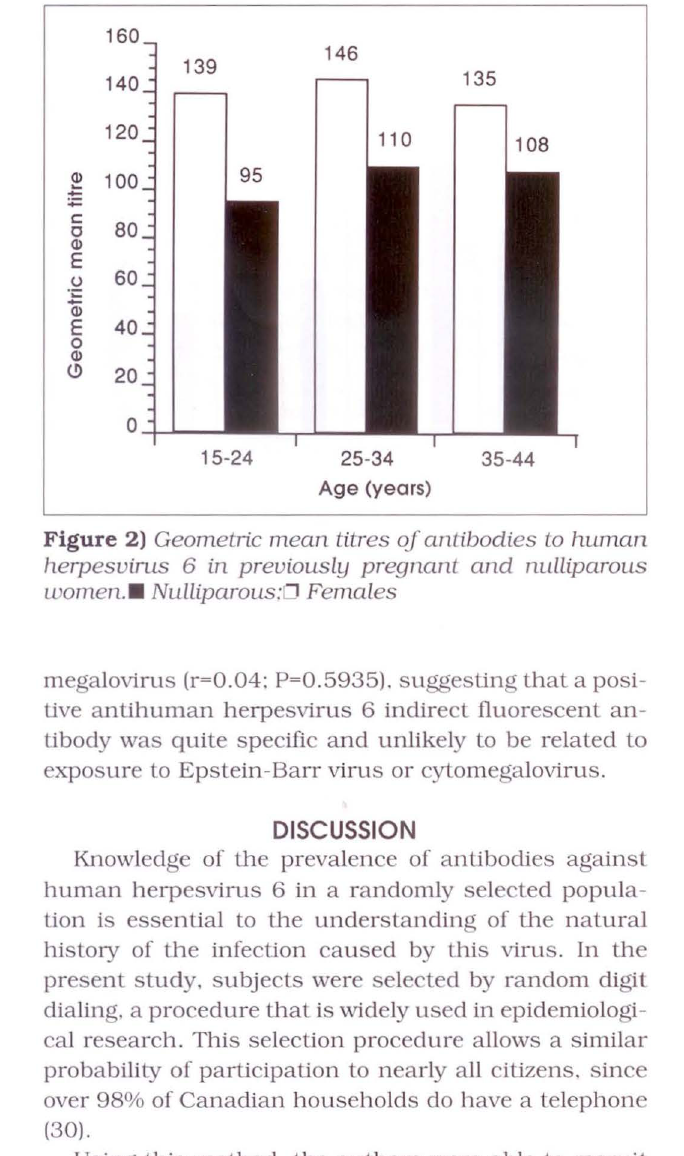
megalovirus (r=0.04: P=0.5935). sugge ling that a